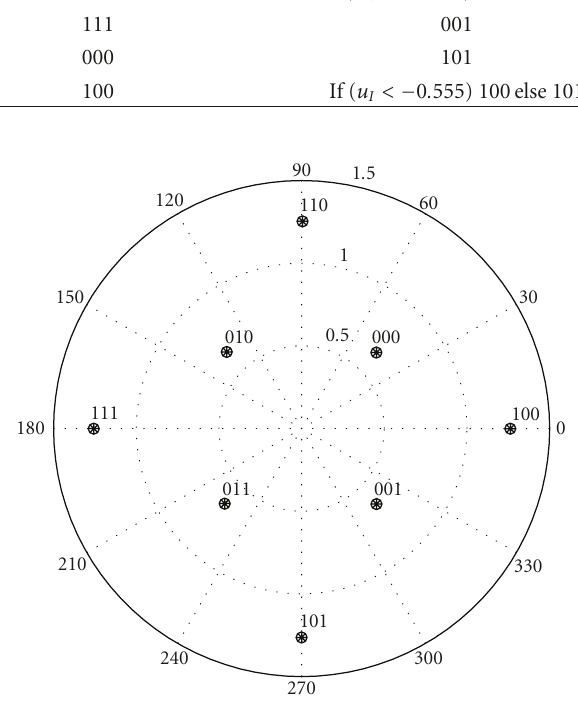
Figure 6: 8QAM constellation of TDMA reference system.